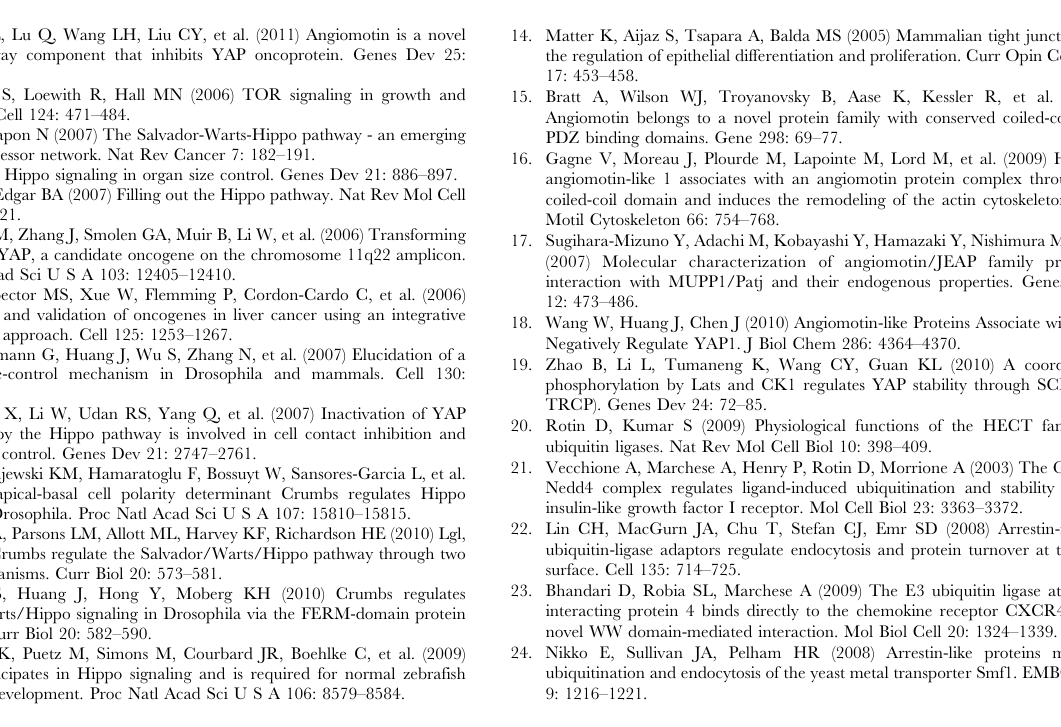
Figure 8. Phosphorylation of Nedd4.2 by c-Abl at tyrosine 71 and 457 inhibits its E3 ligase activity. A , Myc-Nedd4.2 proteins purified from HEK293T cells, co-expressing either wild type or kinase-dead (KD) c-Abl, were analyzed by nanoLC-MS/MS after in-gel digestion and phosphopeptide enrichment. Two singly Y-phosphorylated peptides (Y71 and Y457) were identified. B , Nedd4.2 proteins with Y71F and Y457F substitutions exhibit moderately reduced levels of c-Abl-mediated tyrosine phosphorylation. HEK293T cells were transfected with plasmids encoding myc-tagged wild type (WT) Nedd4.2 or mutants (Y71F, Y457F, or Y71F/Y457F), together with Flag-tagged AMOTL1 and WT or kinase-dead c-Abl, as indicated. Nedd4.2 proteins were precipitated with anti-myc antibodies and blotted with antibodies, as indicated. c-Abl and AMOTL1 were detected in the lysates with anti-Flag antibody. C , c-Abl restricts the ability of Nedd4.2 to extend the poly-ubiquitin chains of AMOTL1. Flag-tagged AMOTL1 (F.AMOTL1) and HA.Ubiquitin were co-expressed with either myc.Nedd4.2 alone, or with myc.Nedd4.2 and V5.cAbl. Ubiquitylated AMOTL1 species, detected by anti-HA antibodies, were shifted from higher molecular weights (poly-Ubi-AMOTL1) above 220 kDa towards lower molecular weight complexes between 100 kDa and 220 kDa (oligo-Ubi-AMOTL1) which are no longer degraded (see text for details). Nedd4.2 Y71F/Y457F is resistant to c- Abl phosphorylation. While c-Abl reduced the molecular weight of ubiquitylated AMOTL1 (left panel), there was no detectable change in molecular weight of ubiquitylated AMOTL1 (right panel) when c-Abl was co-expressed with the double tyrosine Nedd4.2 (Nedd4.2 Y71F/Y457F ) mutant. D , The dual functions of YAP1. Upper panel: AMOTL1 recruits cytoplasmic YAP1 and c-Abl to tight junctions to curtail the ability of Nedd4.2 to poly- ubiquitylate AMOTL1. Lower panel: In cells primed to undergo proliferation, YAP1 translocates to the nucleus. Now, Nedd4.2 poly-ubiquitylates AMOTL1 and targets it for degradation.